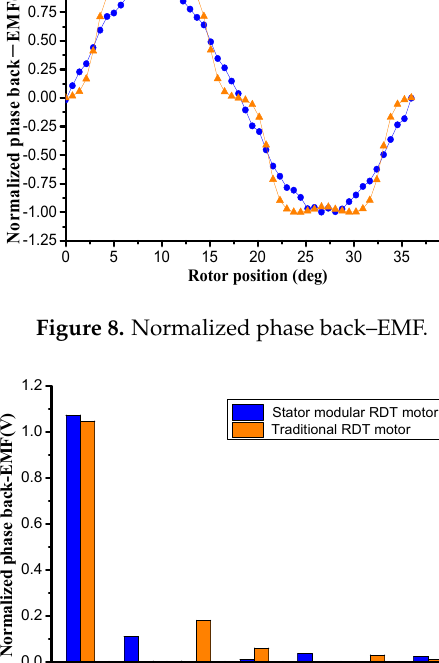
Figure 8. Normalized phase back–EMF.